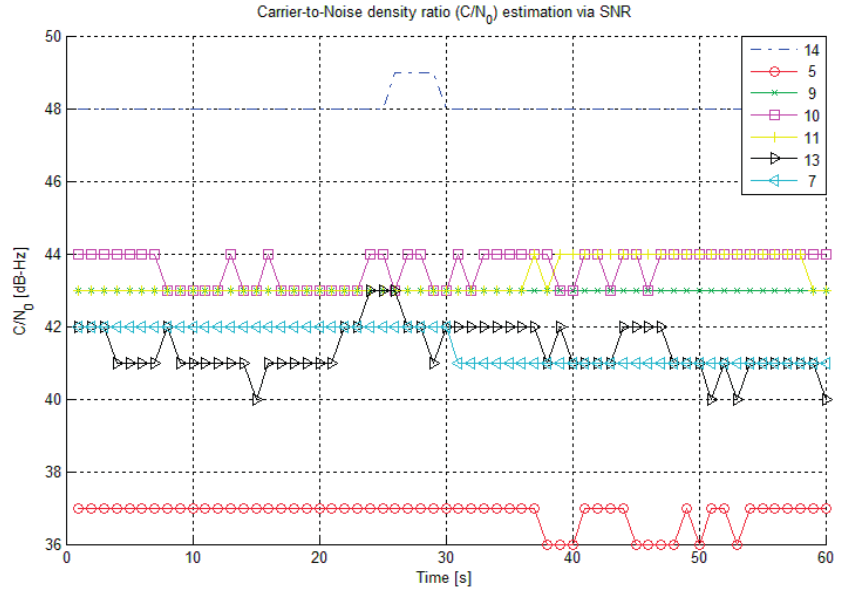
Figure 6. C/N 0 for the tracked BeiDou